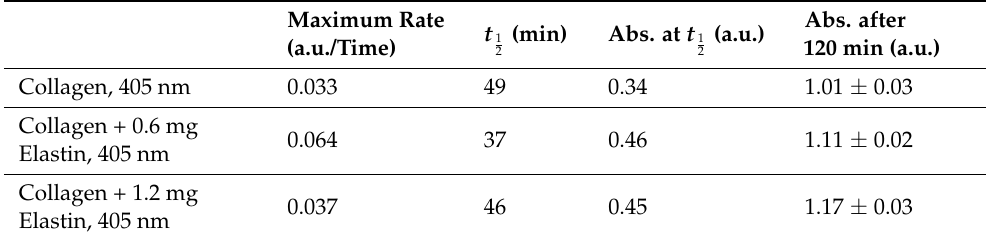
stands for the time where the derivative of the 2 2